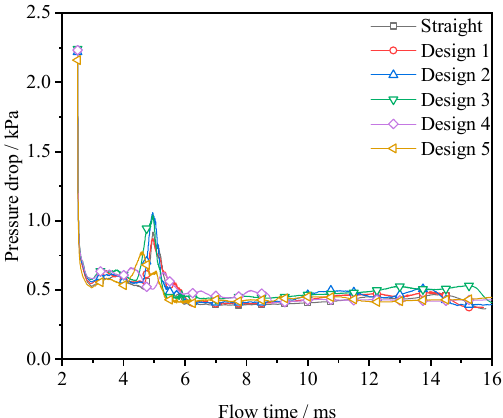
Figure 6. Variation of the two-phase pressure drop during the flow times 2.5–16 ms for different channel designs at same inlet velocity, GDL and wall contact angle (12.5 ms − 1 and θ GDL; side; top = 120°; 82°; 82° respectively).